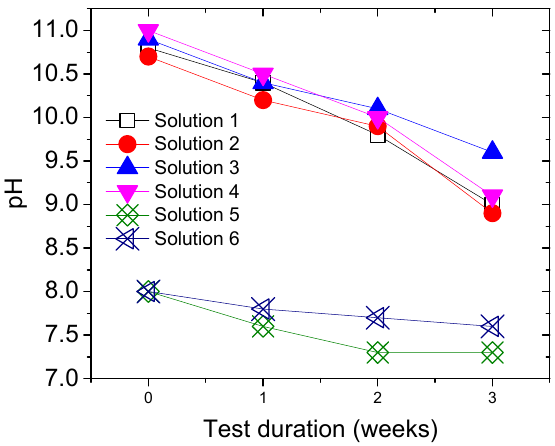
Figure 3. pH of the test solutions as a function of immersion time.